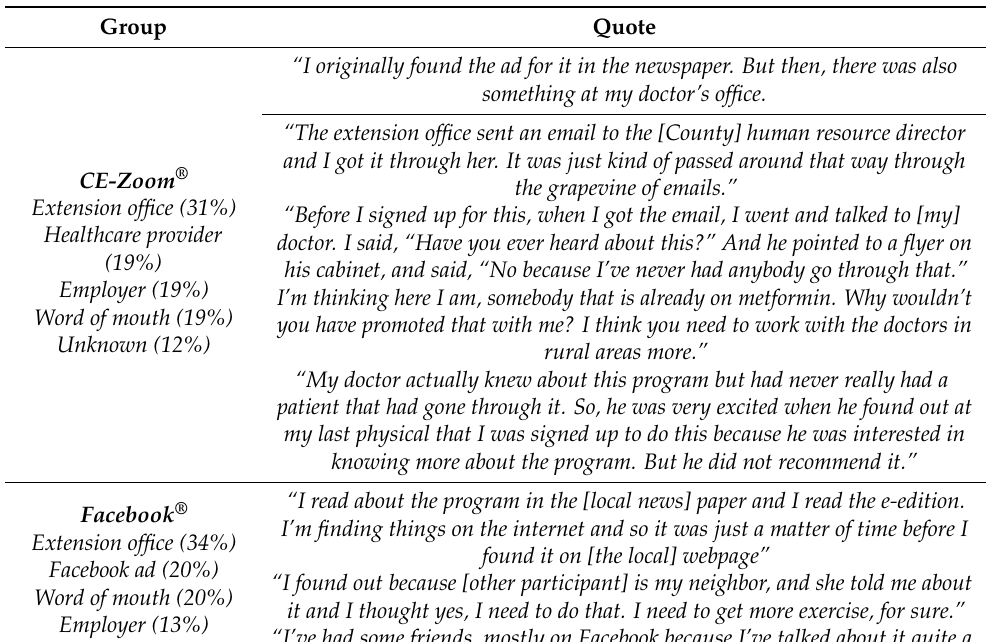
Table 2. Recruitment sources with example